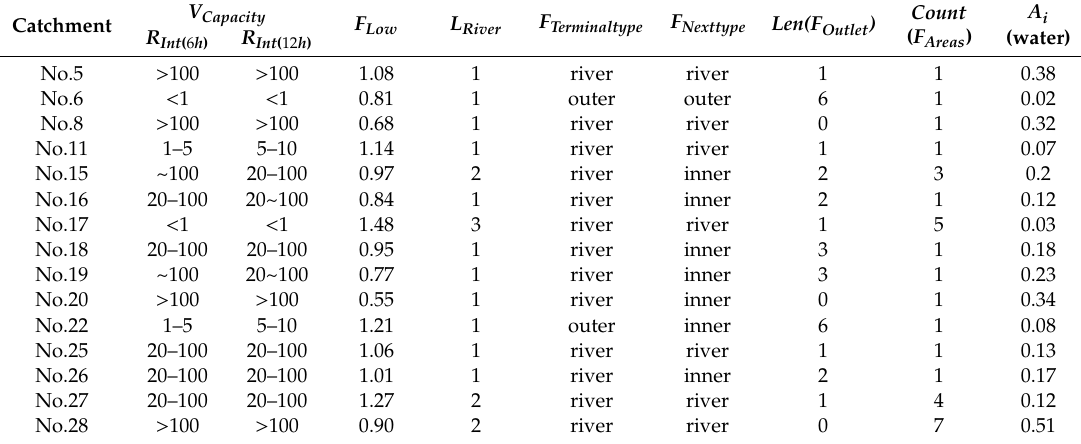
Table 6. The basic indicator used in the study area for flood capacity